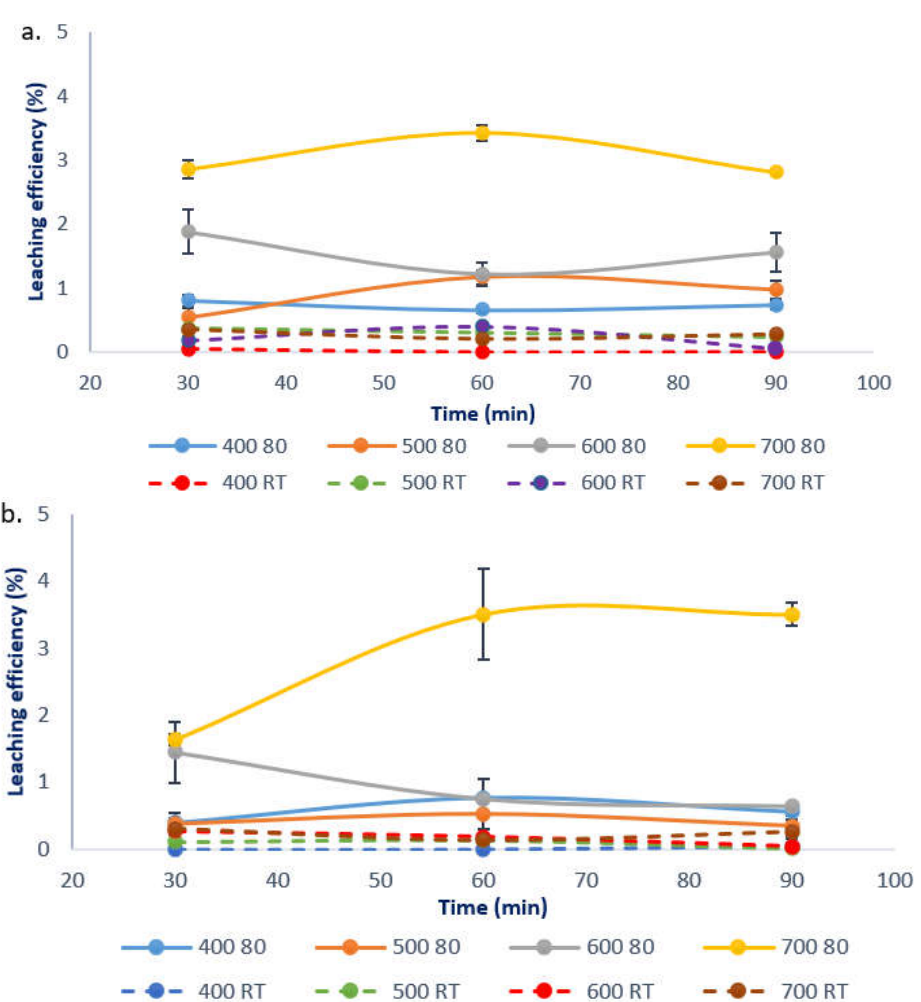
Figure 9. The effect of leaching temperature on Al leaching efficiency: ( a ) pyrolysis and ( b ) incineration (Leaching condition: ( a ). L/S ratio = 20:1 mL g −1 , 80 °C and RT, 300 rpm, and 3 h).